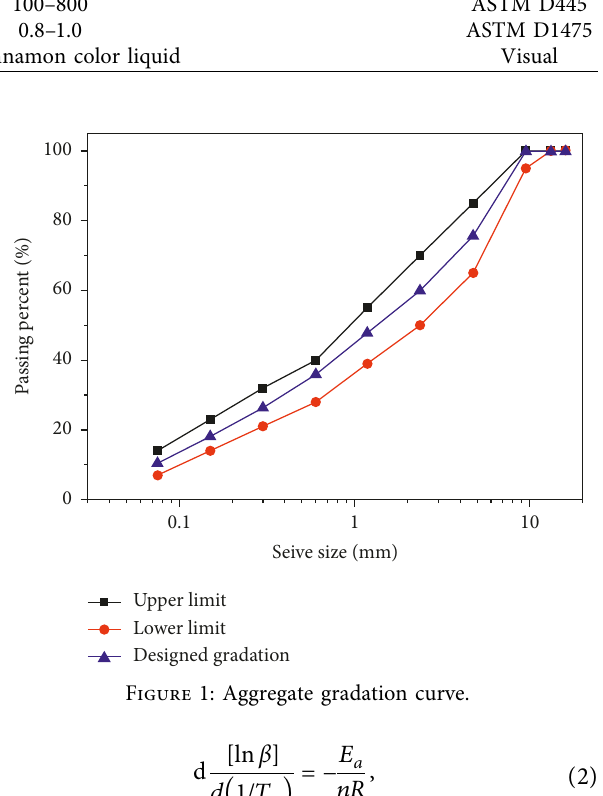
Figure 1: Aggregate gradation